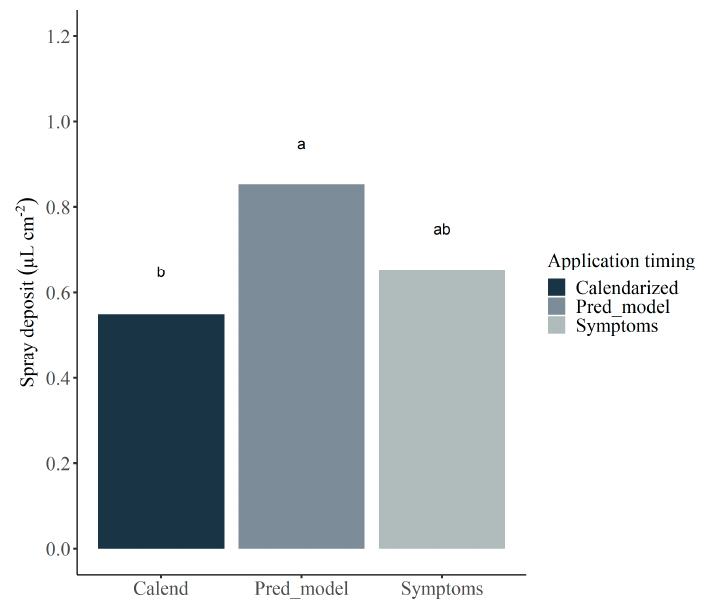
Figure 4. Mean deposit values ( µ L cm − 2 ) that were collected in the upper region of the soybean canopy at different application timings in the first application of Field 1. The means followed by the same letter did not differ by the Tukey test at 5% probability ( p < 0.05).